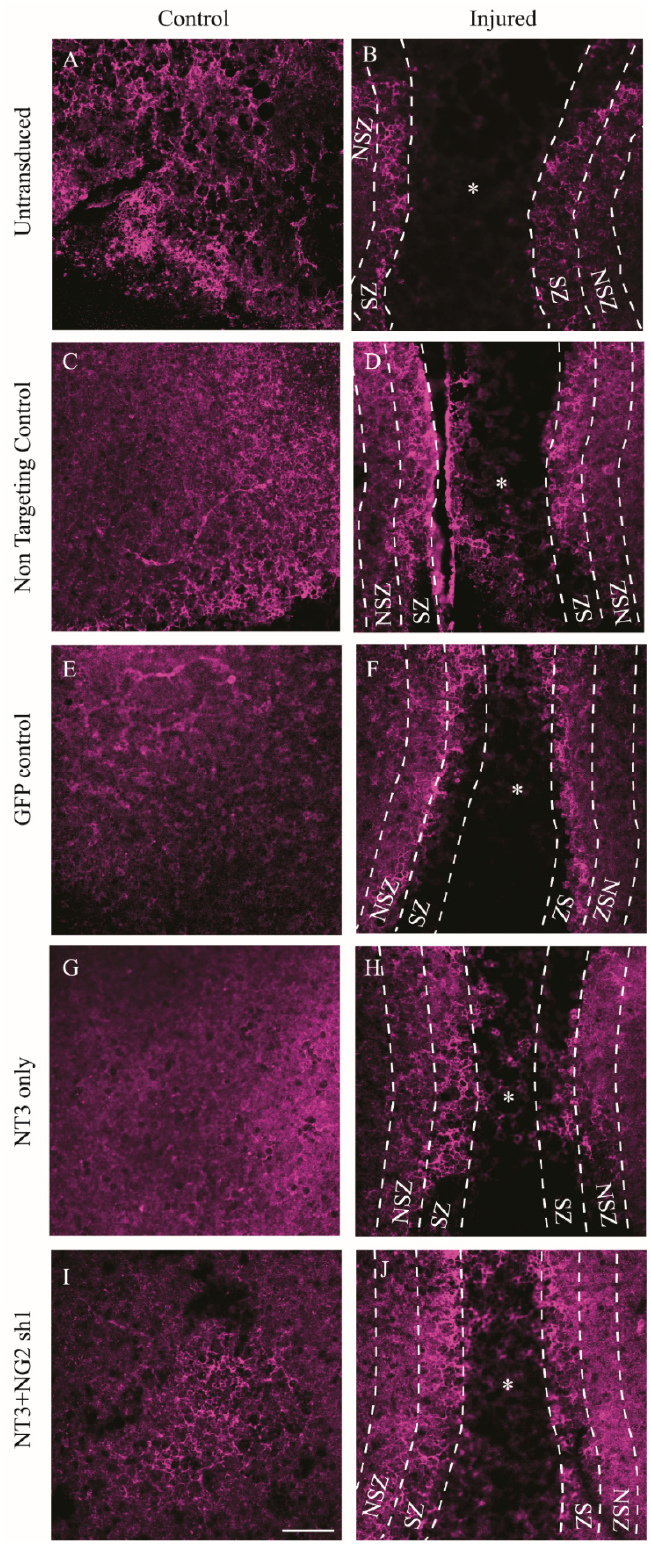
Figure 9. Confocal images showing β III-tubulin expression in untransduced and lentiviral vector transduced control and transection injured ex vivo spinal cord slices. Photomicrographs show projected confocal images of β III-tubulin (purple) in untransduced ( A , B ), non-targeting control ( C , D ), Lenti GFP transduced ( E , F ), Lenti-NT-3-transduced ( G , H ) and Lenti-NT-3 / NG2 sh1 transduced ( I , J ) control and injured slices, respectively. * = injury zone (IZ). Dashed lines separate the regions of interest examined; SZ and NSZ were 100 µm in width. Scale bar = 100 µm.